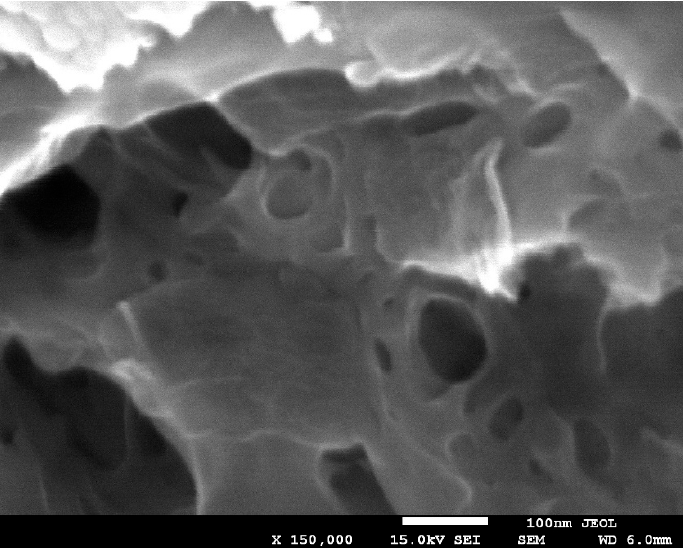
Figure 3. SEM micrograph taken at 150,000 magnification: ALG/Ag/GOX foil.